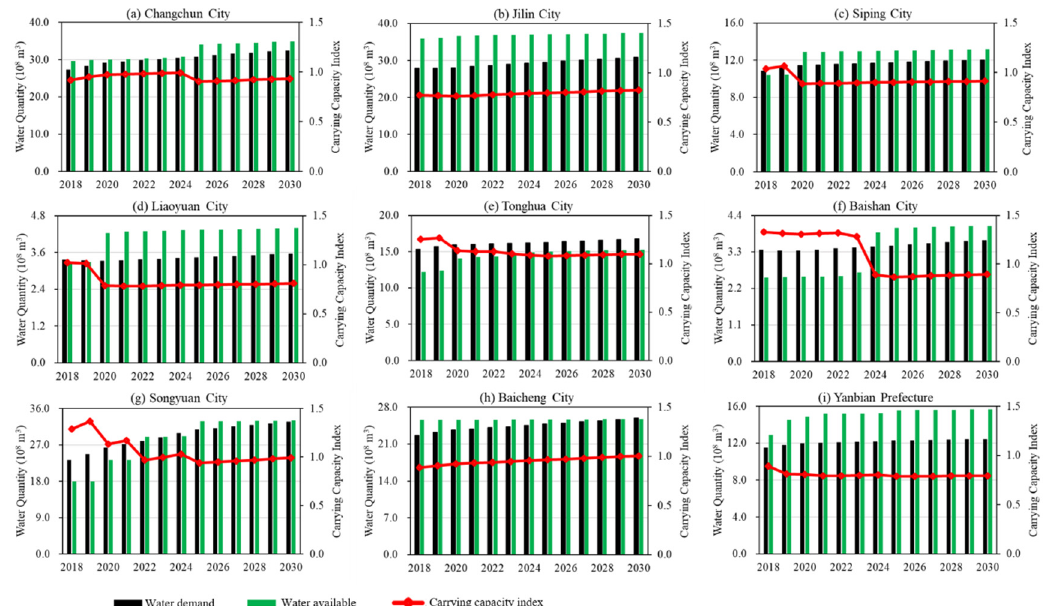
Figure 5. Simulation results of water demand/available in nine cities from 2018 to 2030.